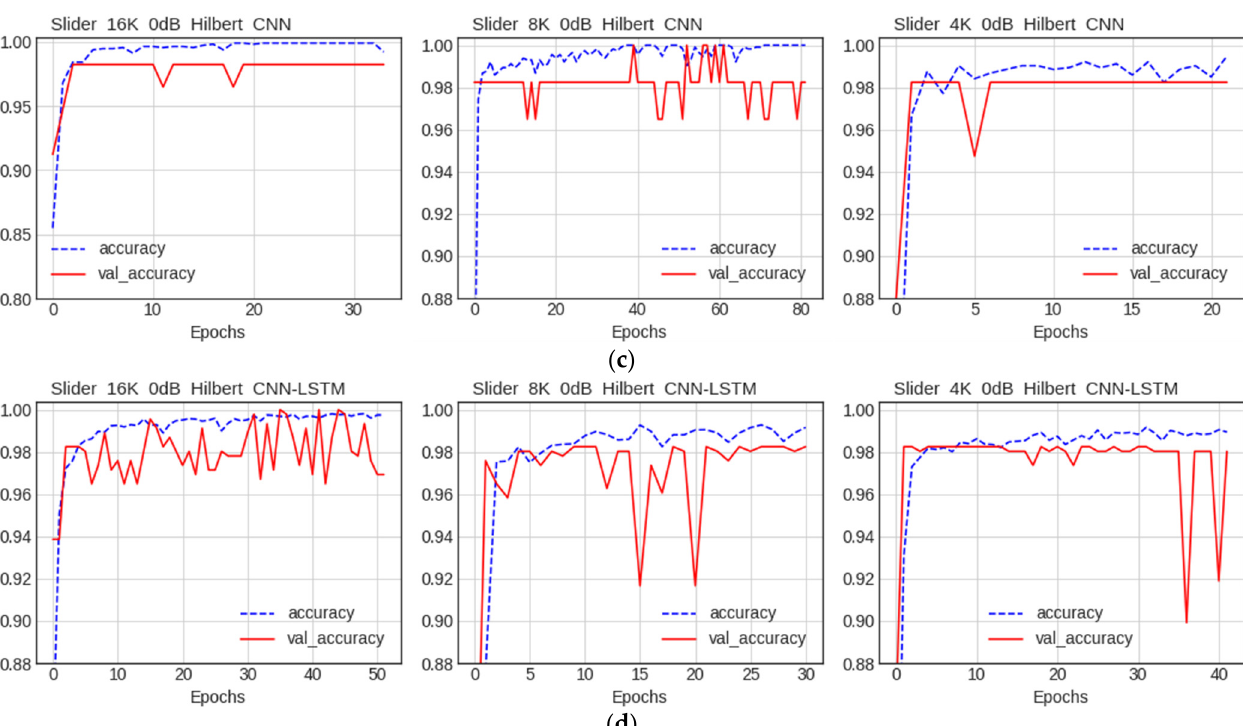
Figure 17. Accuracy of using data after preprocessing with Hilbert transform after changing the data quality to 4 K, 8 K, and 16 K: ( a ) result of valve data training on the CNN model; ( b ) result of valve data training on the CNN–LSTM model; ( c ) result of slider data training on the CNN model; and ( d ) result of slider data training on the CNN–LSTM model.